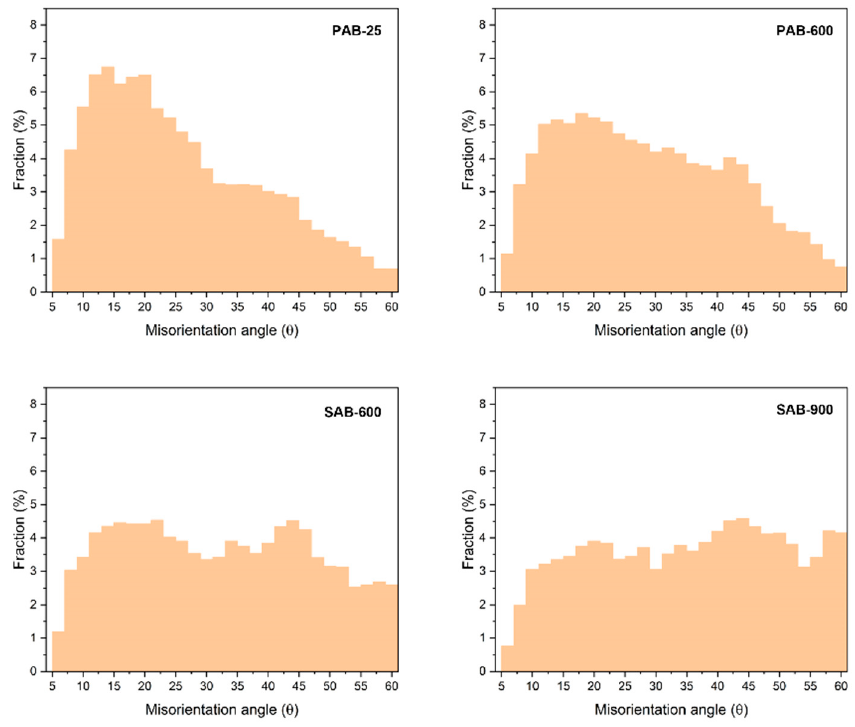
Figure 5. Misorientation distribution of primary-arc beads (PABs) and secondary-arc beads (SABs).